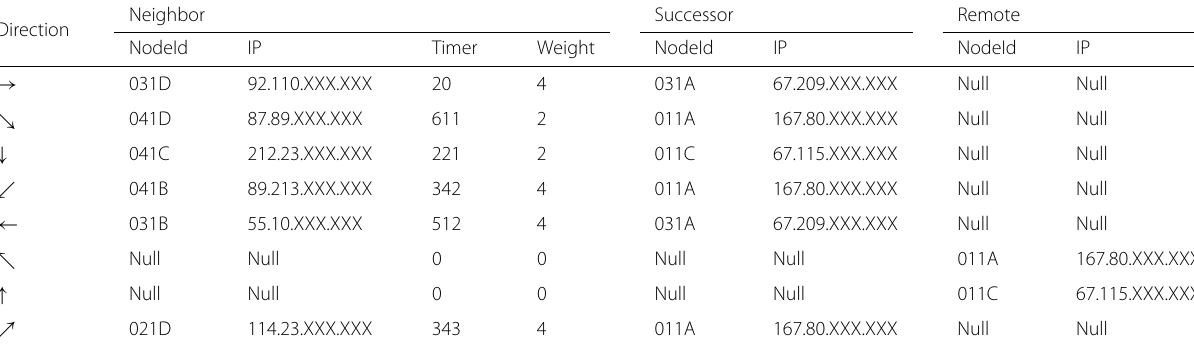
Table 1 Routing table entries for node 031C in Fig. 2a